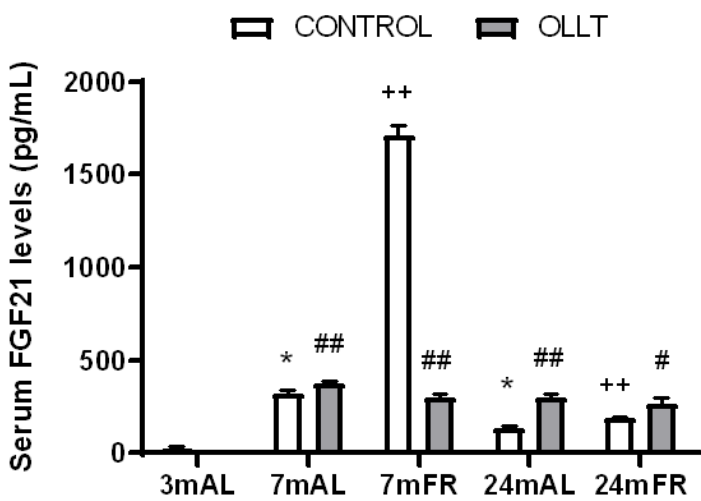
Figure 10. Serum levels of the FGF21 in the 3-, 7-, and 24-month-old rats fed ad libitum (AL) or food-restricted (FR), before (CONTROL) and after an oral lipid loading test (OLLT). Results are the mean ± SEM of 8–10 rats per group, conducted in duplicates. Unpaired Student’s t -test, * p < 0.05 compared to the 3-month-old rats under the same feeding protocol; ++ p < 0.0001 compared to the age-matched ad-libitum-fed rats; # p < 0.05, ## p < 0.0001 compared to the basal levels before a fat load of the age-matched rats under the same feeding protocol.